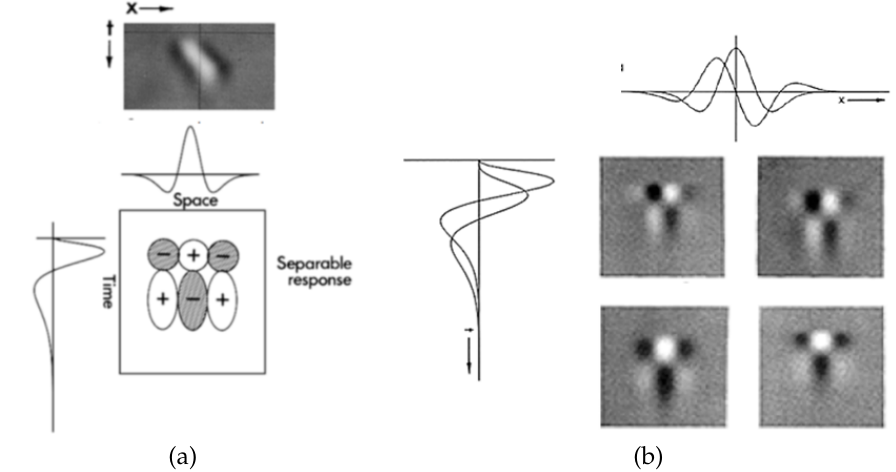
Figure 1. ( a ) Response of a spatio-temporal filter; ( b ) responses of a combination of couples of spatial and temporal filters having different